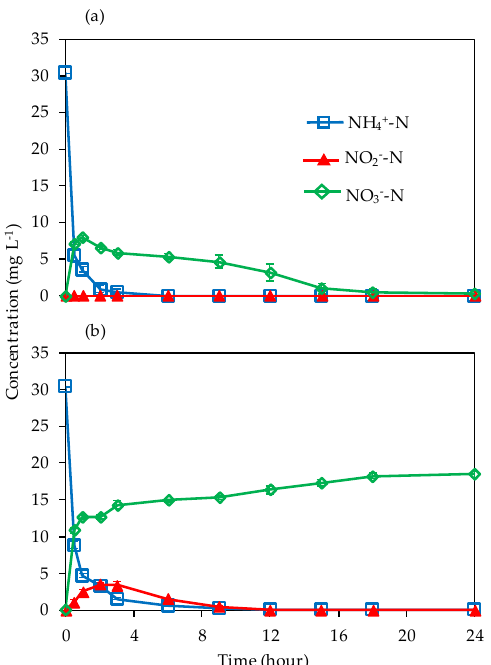
Figure 5. Changes in N concentrations in groundwater inside tidal flow CWs: ( a ) with vegetation (common reed plants), and ( b ) without vegetation. Values are means ±SD (n = 3).